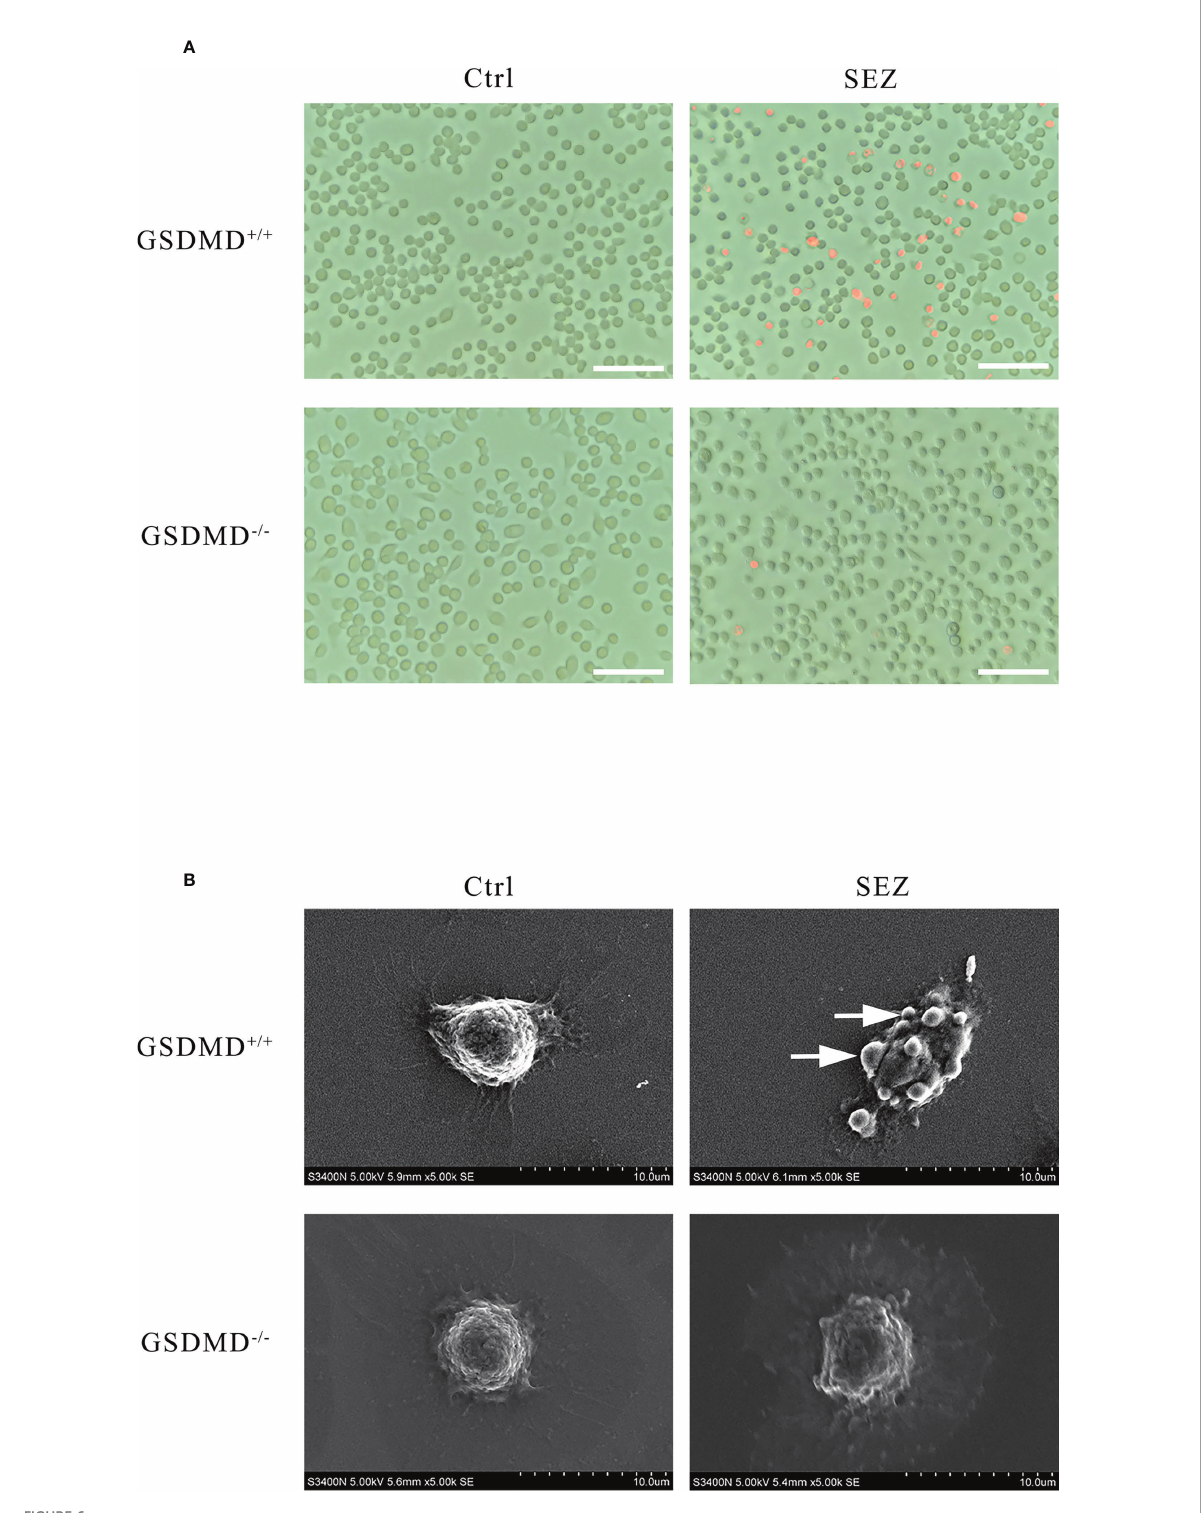
FIGURE 6 Peritoneal macrophages have distinct morphological features of pyroptosis after SEZ infection. (A) Representative propidium iodide (PI) staining of GSDMD +/+ or GSDMD -/- macrophages after being infected or uninfected with SEZ. (B) Representative scanning electronic microscopy (SEM) images of GSDMD +/+ or GSDMD -/- macrophage cells are treated as above, and the arrow points to the bubbling of pyroptotic cells. Scale bar, 70 m m (A) . These experiments were conducted with 3